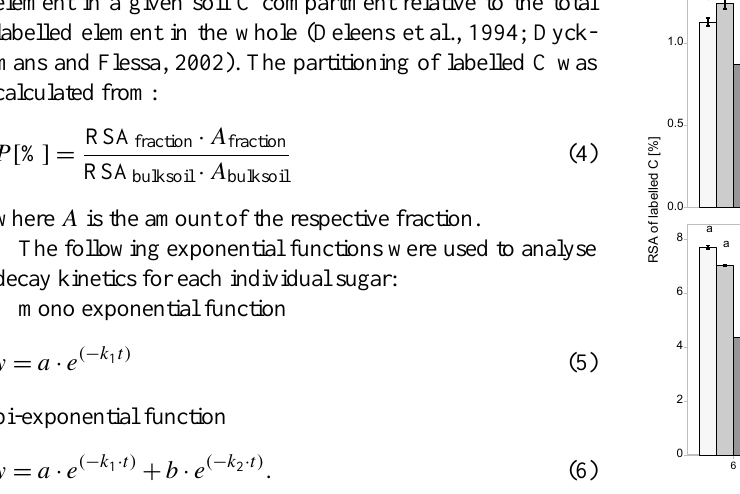
Figure 1. Fraction of labelled C in total C of bulk soil C, micro- bial biomass (C mic ) , respired CO 2 , and K 2 SO 4 -extractable carbon (exC) of the wheat Ap and E, grassland Ah and forest Ah after 6, 20 and 34months of incubation. Different letters indicate signifi- cant differences ( p <0.05) within one treatment over time. Means ± standard error ( n =